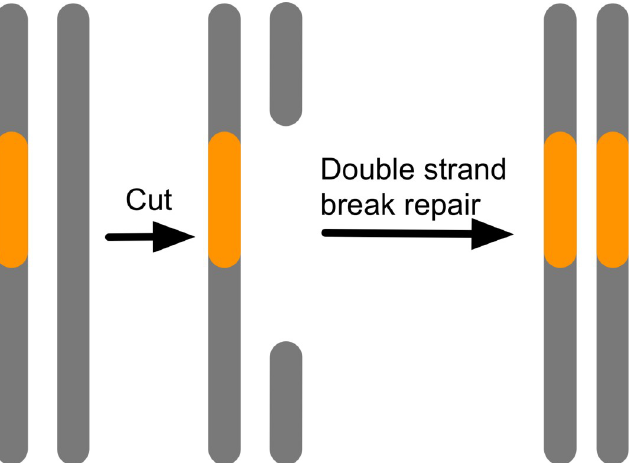
Fig 3. Homing endonucleases can recognize a target sequence, cut it, and then use it own sequence as a template during double strand break repair. This converts a heterozygote into a homozygote.